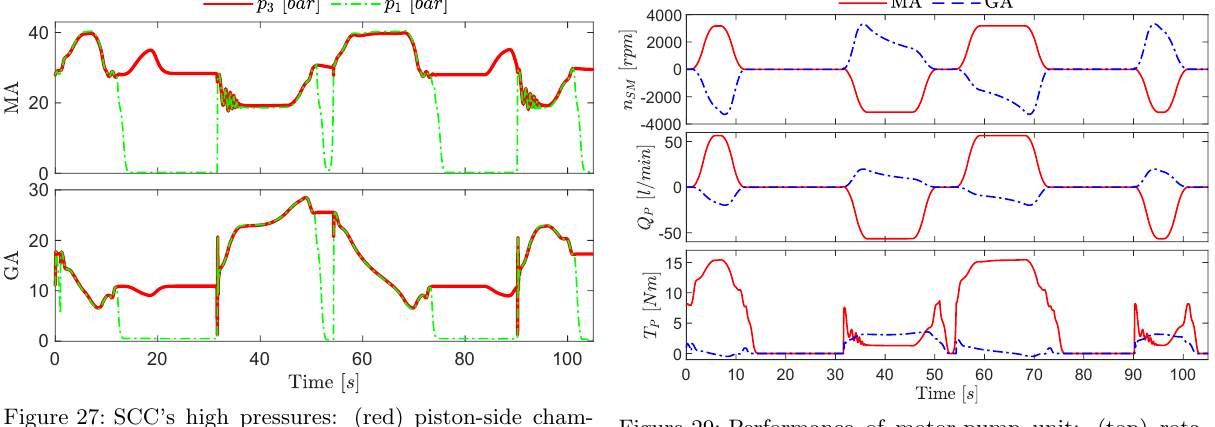
Figure 29: Performance of motor-pump unit: (top) rota- tional speed of the servo-motors; (middle) sup- plied flow to the cylinders; (bottom) torque de- mand of the pumps.